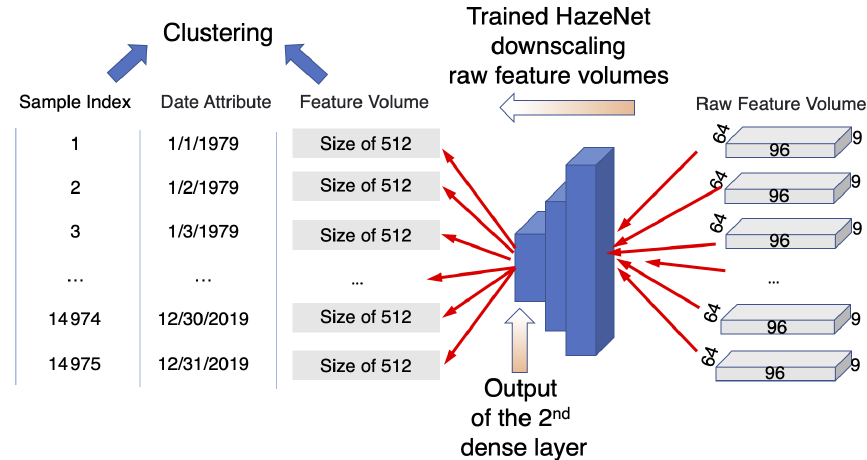
Figure 6. A diagram of the cluster analysis procedure. Here 96, 64, and 9 represent the number of longitudinal grids, latitudinal grids, and features (variables) or the size of the input feature volume of a trained HazeNet for Beijing cases, respectively, while 512 is the size of the output from the dense layer before the output layer of HazeNet or the size of new feature